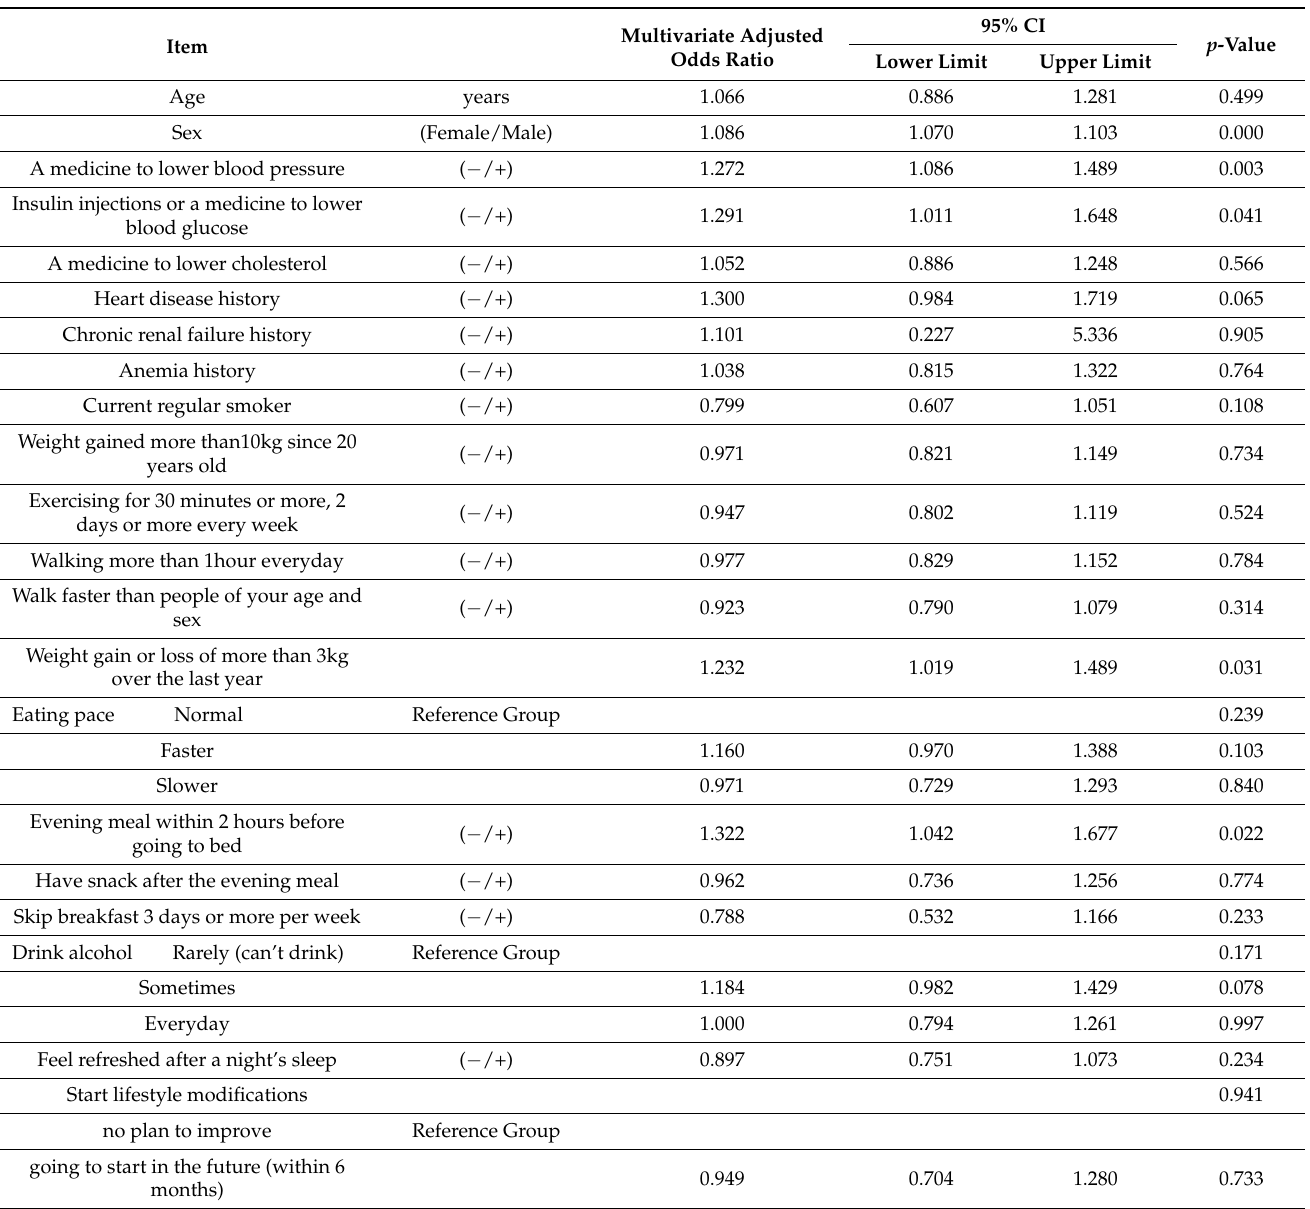
Table 4. Multivariate logistic regression analysis of questionnaires administered in